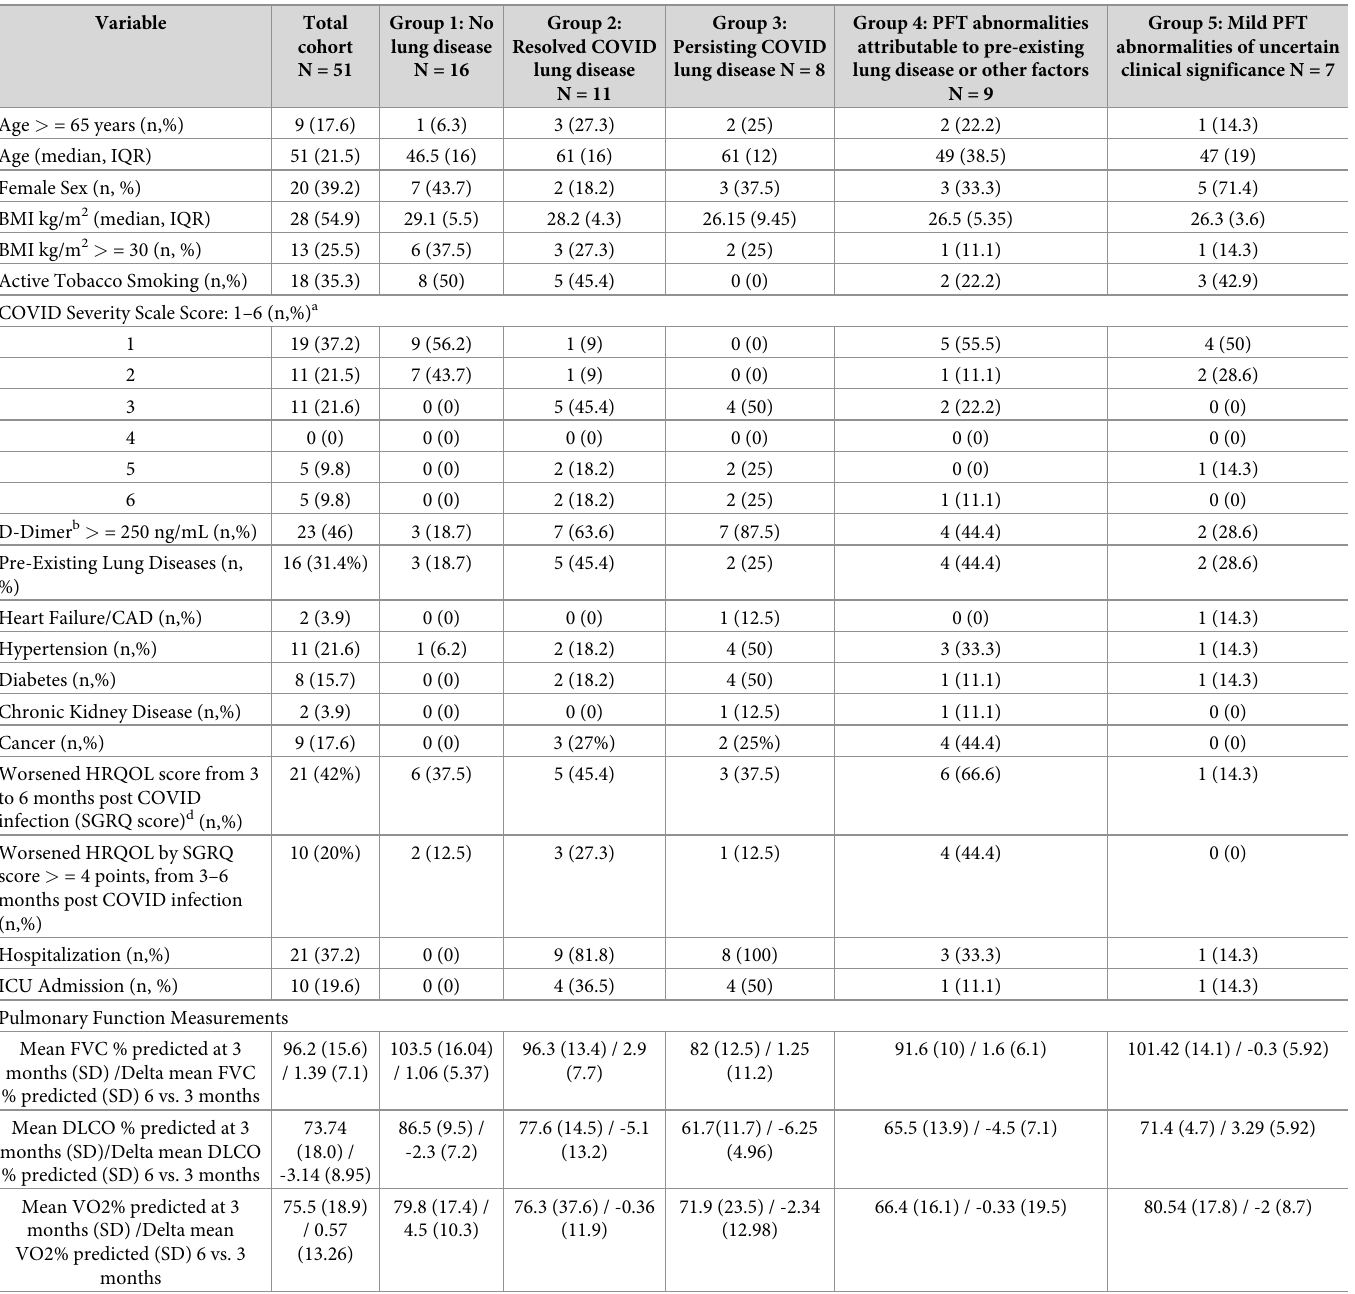
Table 1. Characteristics of the study